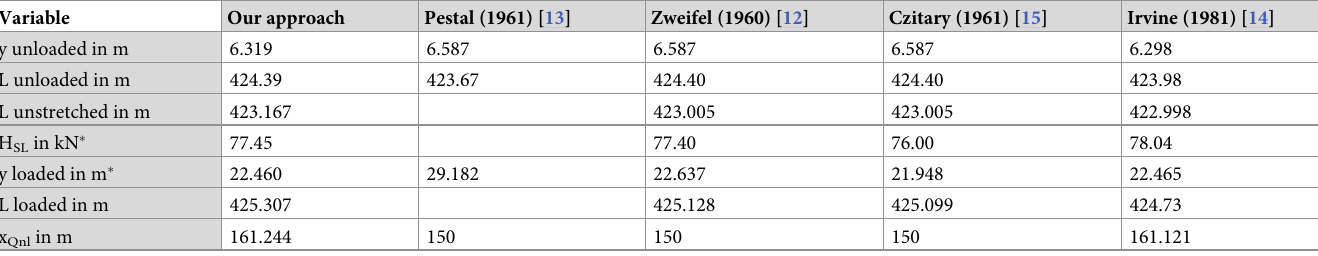
Table 3 inclined example with b = 300 m, h = 300 m , E S = 100 kN/mm 2 , Q = 2000 kg � 9.81 m/s 2 , q 0 = 17.564 N/m (diameter 20 mm), f T = 0,606, S 0 = 60 kN (located at h 0 ); � at position of max.